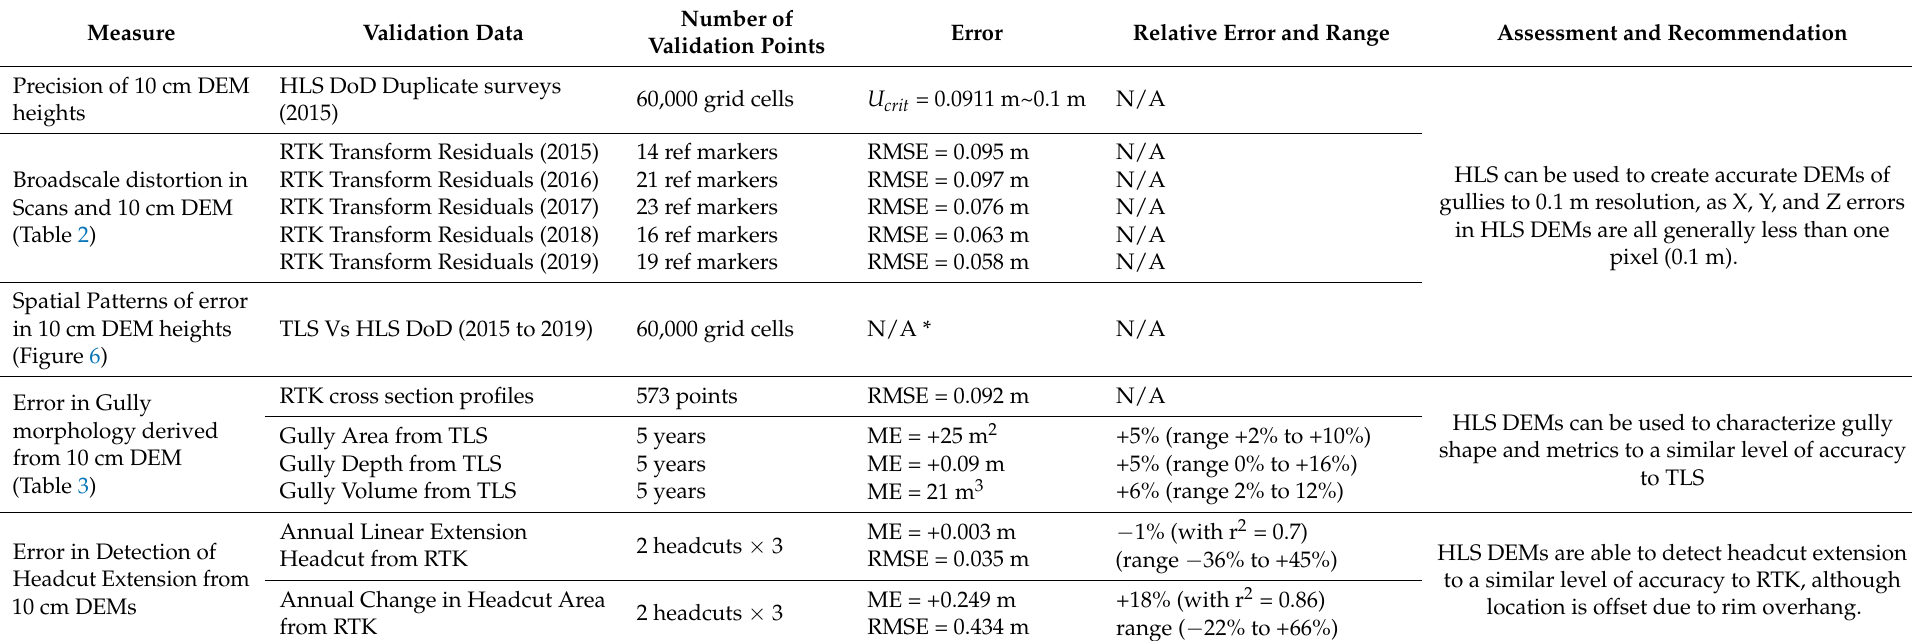
Table 5. Summary of errors in HLS Gully